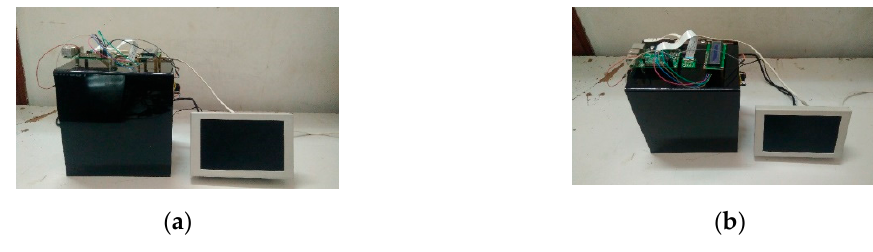
Figure 12. Hardware implementation system: ( a ) Box front view; ( b ) box top view.